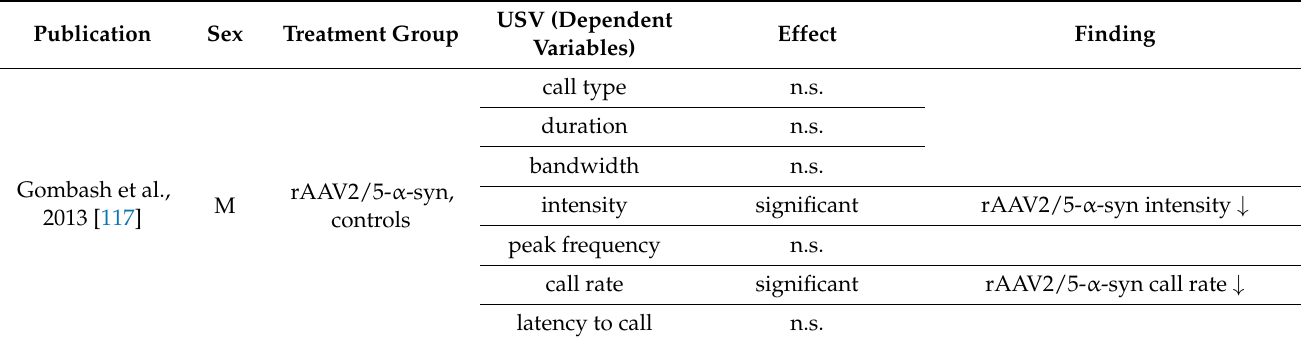
Table 2. Summary of effects of alpha-synuclein treatment on USV